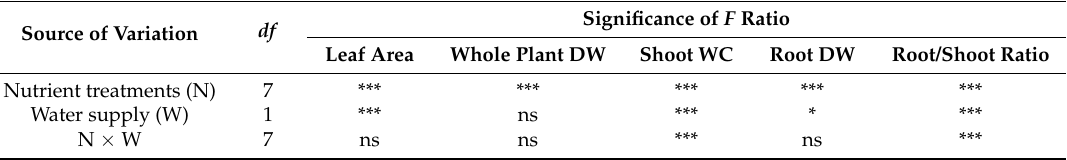
Table 4. Analysis of variance (ANOVA) results for leaf area, whole plant dry weight (DW), shoot water content (WC), root dry weight (DW) and root/shoot DW ratios at day 20 after sowing. df